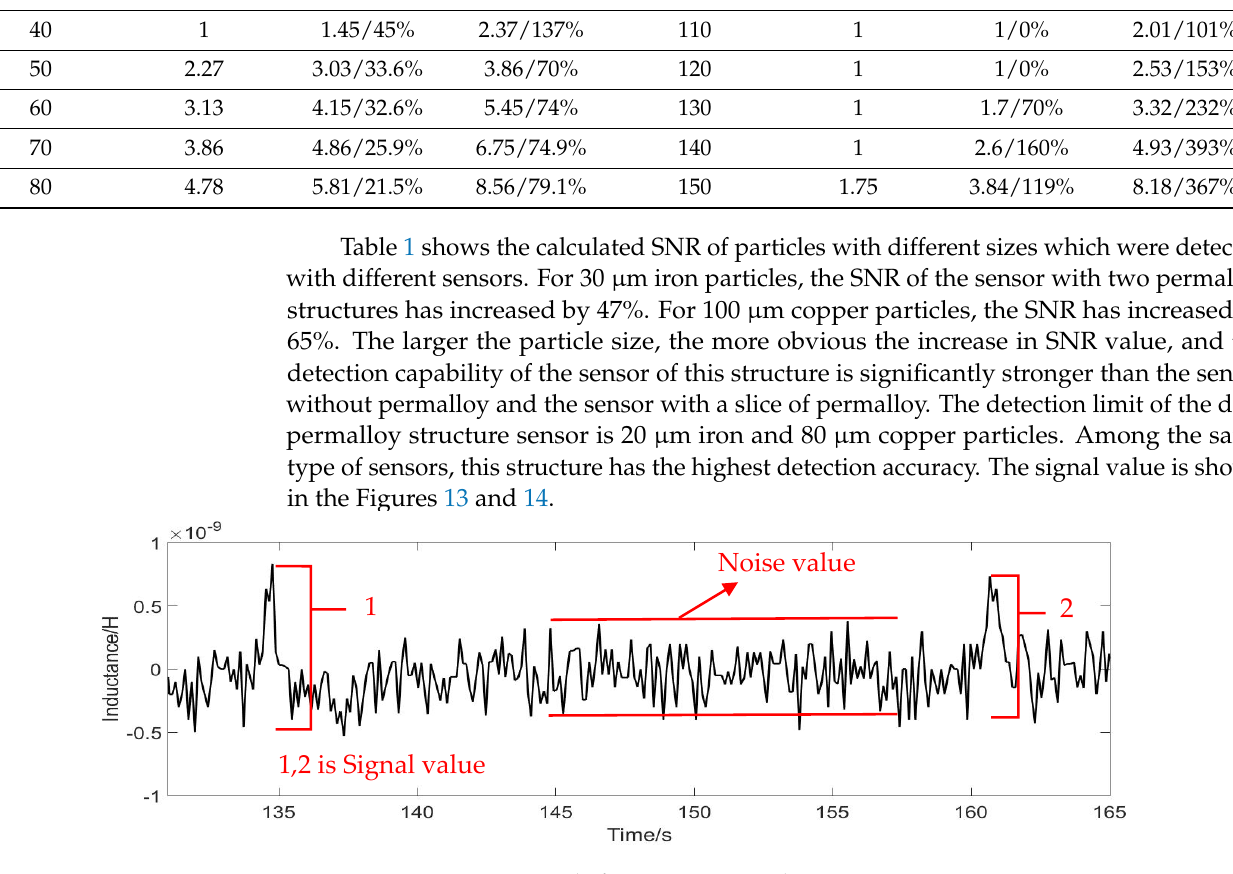
Figure 13. Signal of 20 μ m iron particles.